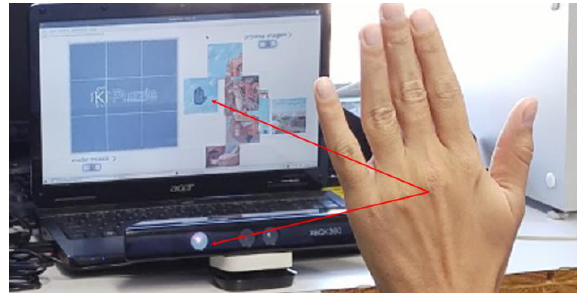
Fig. 3. GesturePuzzle interface is running from gestural interaction. Upper limb movements can be explored at many levels and ranges of motion (coronal, sagittal and transverse – Figure 4), allowing control from both the standing or sitting position.